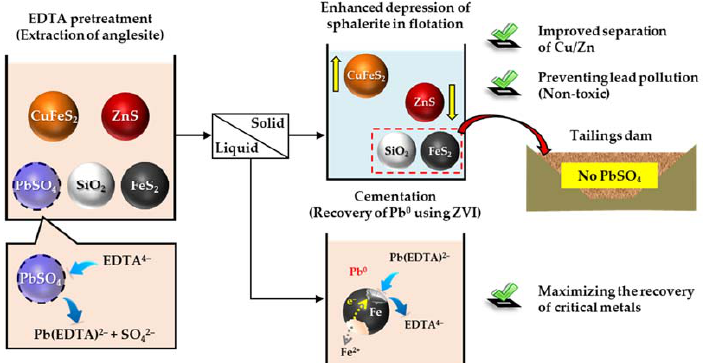
Figure 10. Proposed enhanced depression of sphalerite (ZnS) by extracting anglesite (PbSO 4 ) using ethylene diamine tetra acetic acid (EDTA) and recovery of the extracted Pb 2+ as zero-valent Pb (Pb 0 ) by cementation using zero-valent Fe (ZVI).